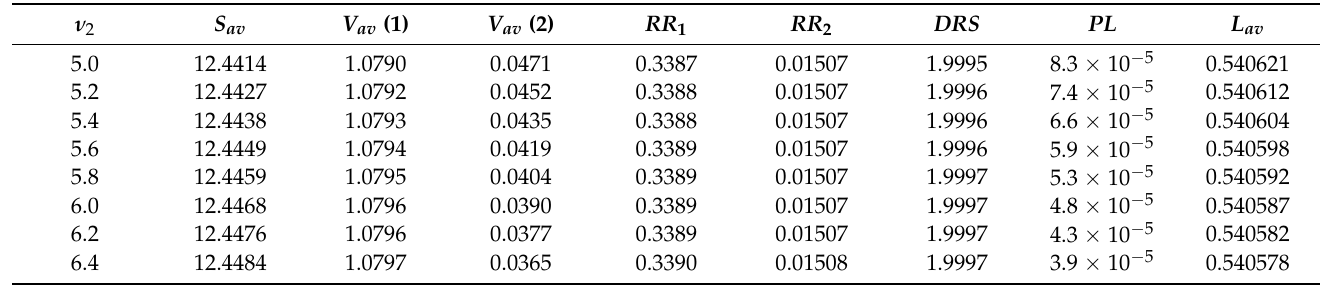
Table 7. Dependence of the performance measures on parameter ν 2 ; λ = 2, µ 1 = 5, µ 2 = 6, κ = 2, ν 1 = 3, τ = 2, r = 3, s = 8, S = 18.